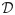
Benign strain is dominant in all three conditions of co-infection delay (D).Introduction of the benign strain (B) 30 steps before the introduction of the malignant strain (D=+30), or simultaneously (D=0) greatly hampers the spread of B strain but introducing this strain 30 steps after the introduction of M strain (D=-30) tighten the competition between the strains. Each trajectory is the average of 100 runs. The shaded areas contain the trajectories of all the 100 runs for the given parameters. For virus M, all the parameters of probability distributions to generate the
waiting times were set as one. For virus B, the waiting times had been generated from Exp(λ = 3)and Weibull(λ = 1, ω = 0.5). The immune system was not active in all the runs.